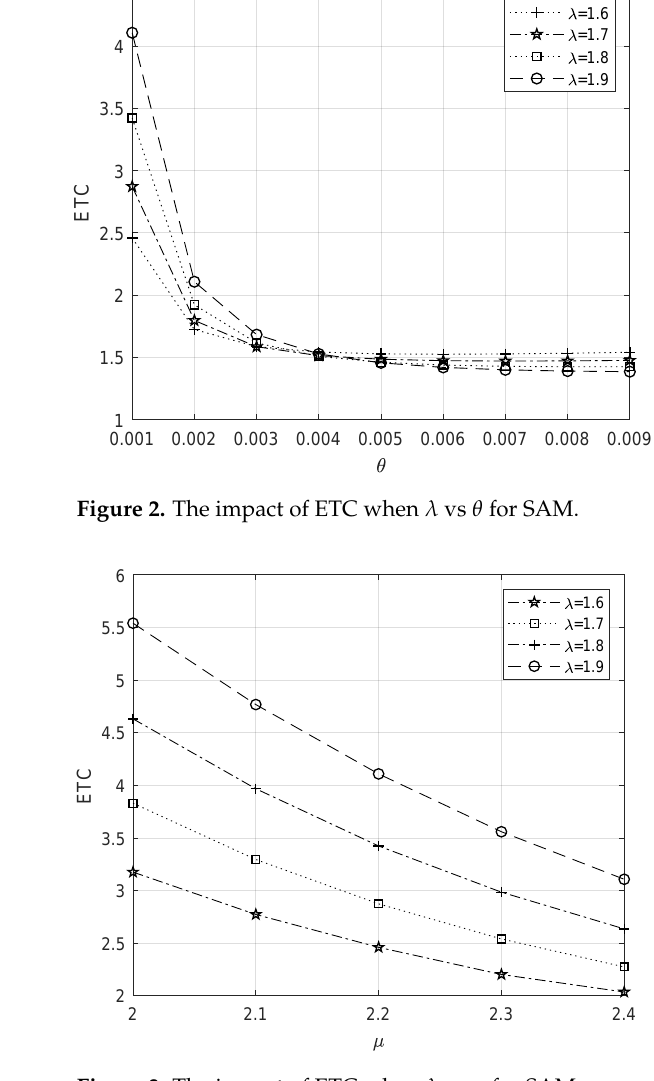
Figure 3. The impact of ETC when λ vs µ for SAM.